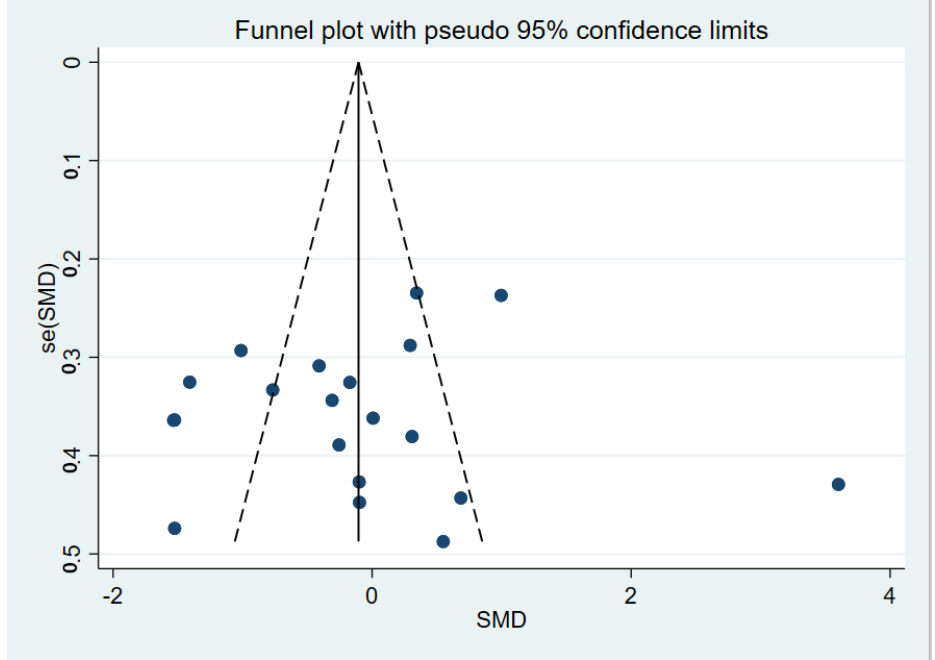
Figure 4. Meta-analysis on the funnel map of P3b amplitude of TD patients and HCs. SMD: Standard Mean Difference.